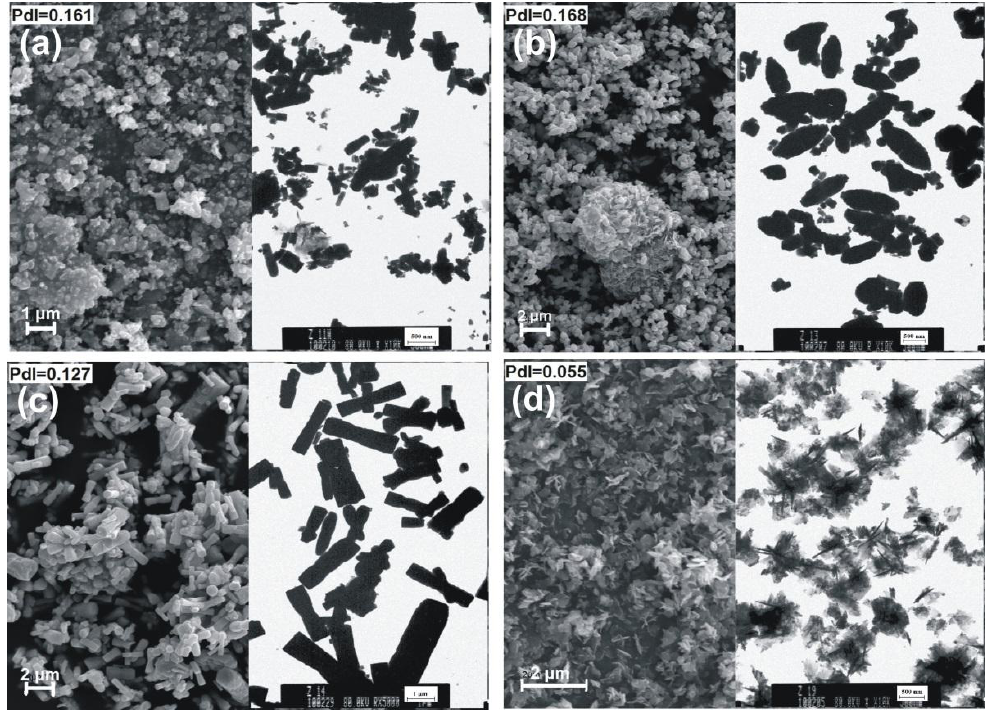
Figure 4. Zinc oxide structures: ( a ) solids; ( b ) ellipsoids; ( c ) rods; and ( d ) flakes